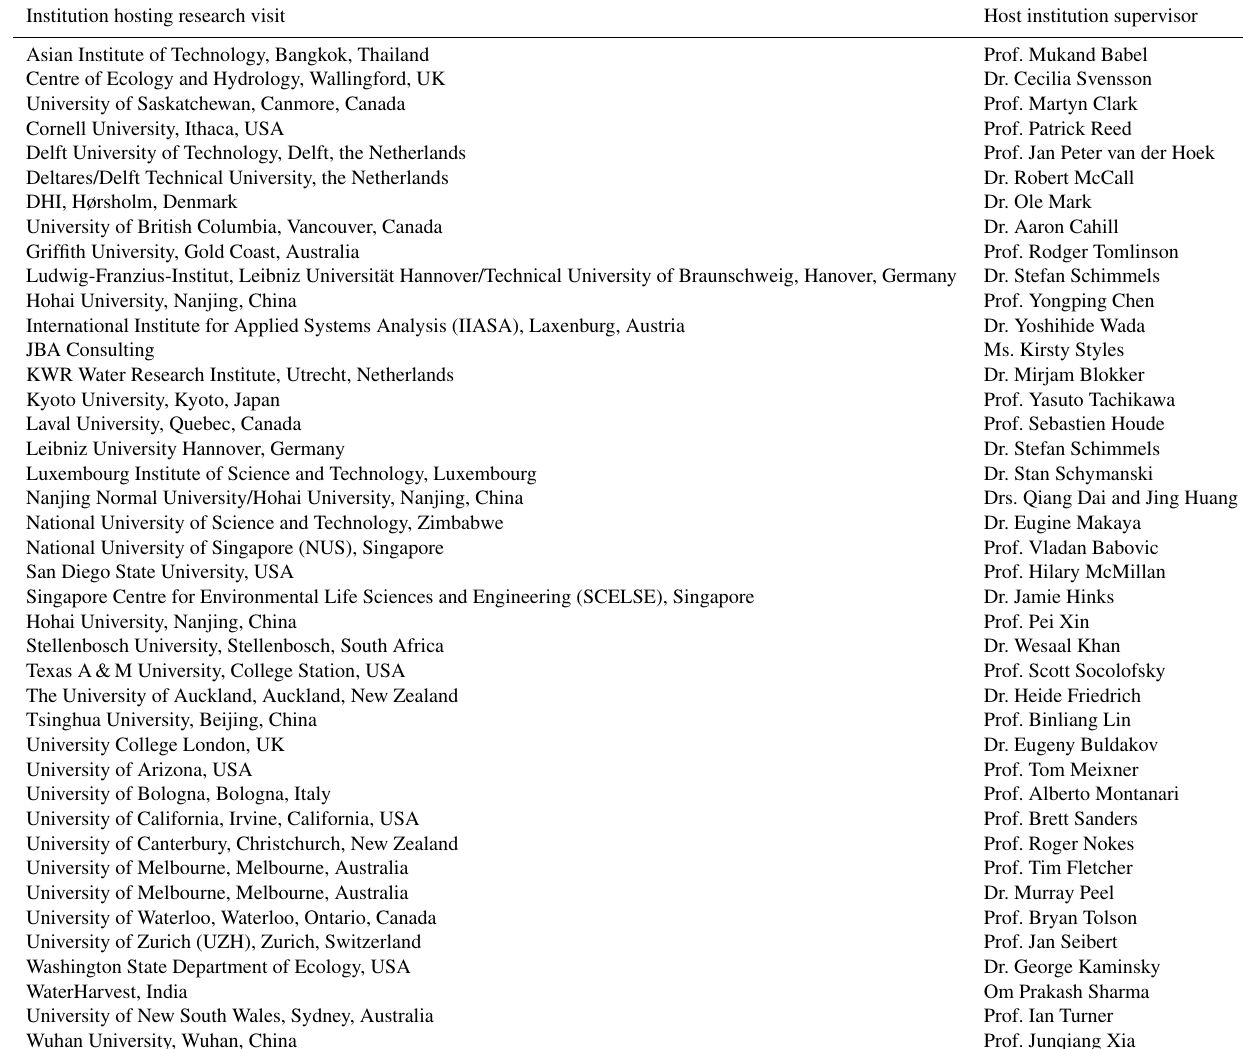
Table 2. Research visit